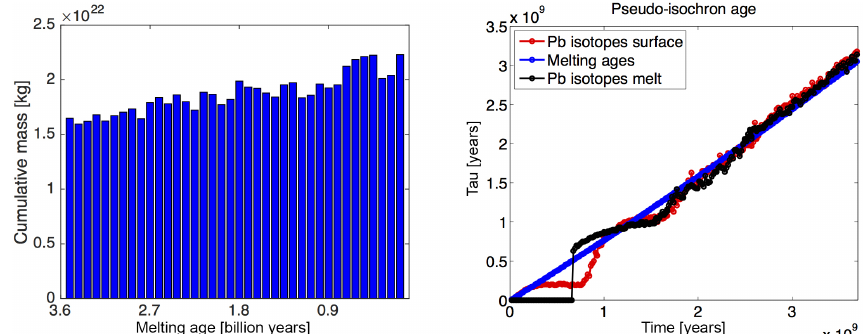
Figure 9. Pseudo-isochron ages calculated. (left) Histogram of the melting ages. The height of the bins shows the summed mass represented by all the particles that have a melting age that falls in that bin. (right) Pseudo-isochron ages as determined via the Pb isotopes sampled at the surface (red), the melting ages distribution (blue), and Pb isotopes sampled at the melt (black). The horizontal axis shows time since the start of the calculation and the vertical axis the pseudo-isochron